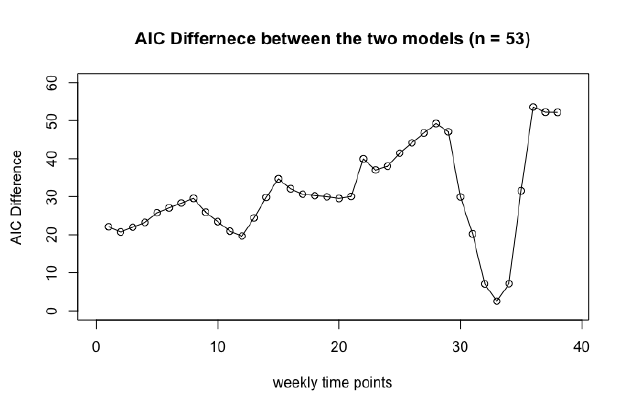
Figure A1. AIC difference over 38 weeks of pregnancy with the outlier.